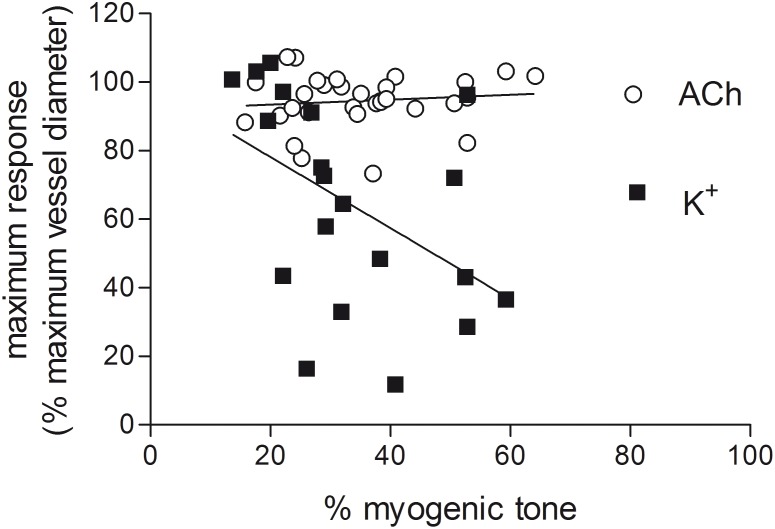
Vasodilator responses to raised extracellular potassium correlate with the degree of myogenic tone.The relationship between the level of myogenic tone (in the presence of L-NAME (100 µM) and indomethacin (1 µM)) and the Rmax for ACh (n = 31) or raised extracellular potassium (n = 20) in rat isolated mesenteric arteries pressurised to 90 mmHg. Each point represents one experiment. The slope of the line fitted to the potassium data was significantly different from zero (P<0.05) with an r2 = 0.2387. The slope of the line fitted to the ACh data was not significantly different from zero.